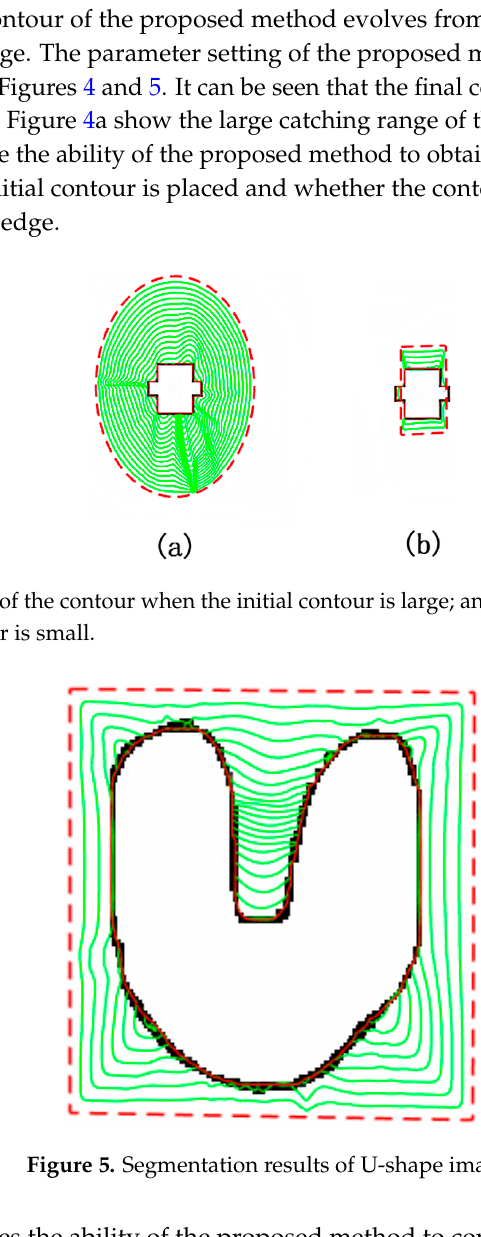
Figure 6. LTI (Long and Thin Indentation) convergence results of all models.